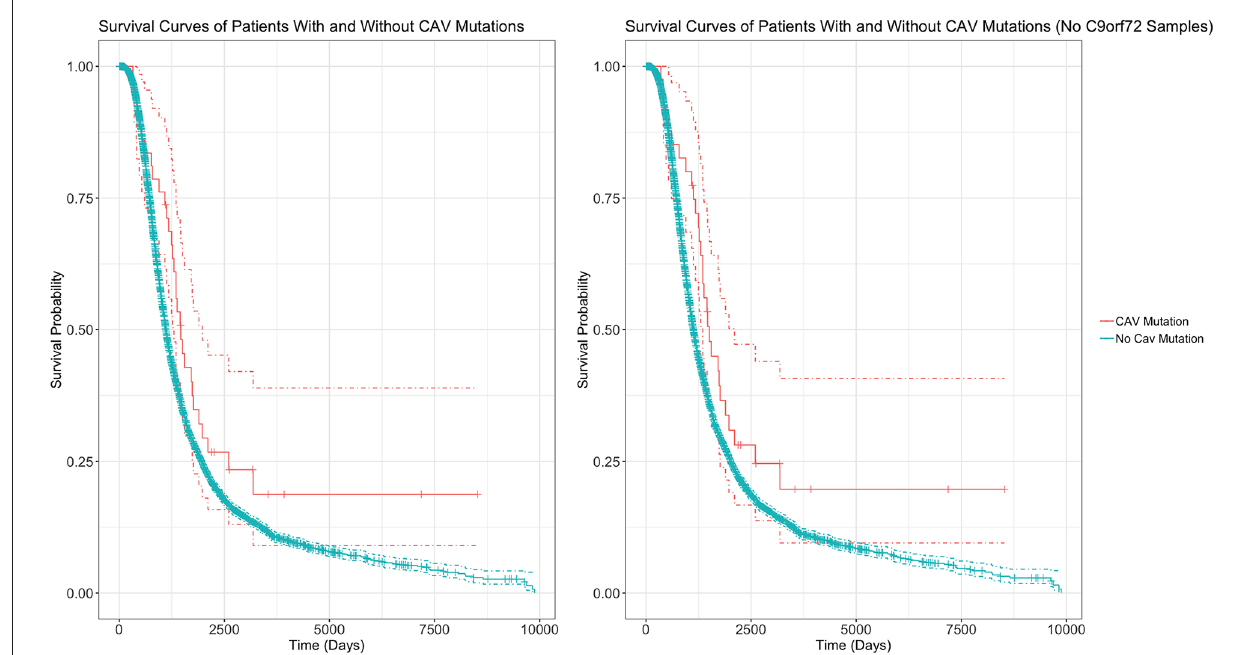
FIGURE6 Survival Curves comparing survival of patients with vs without any CAV1/2 mutation. The left graph is based upon data from Analysis 1, inclusive of patients with C9orf72 repeat expansion. The right graph is from Analysis 2, with C9orf72 samples removed. Patients with CAV1/2 mutations